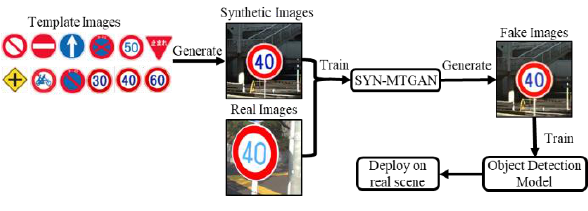
Figure 2. Flowchart of our proposed